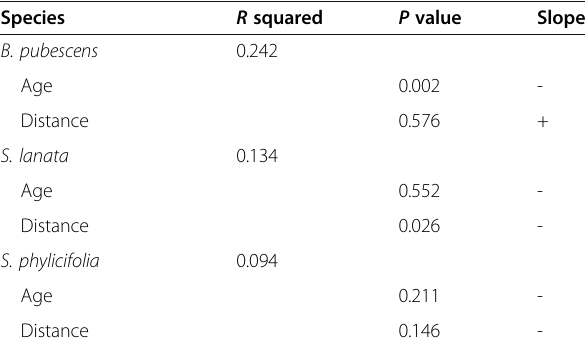
Table 5 Multiple linear regression analysis results testing data for size of specimens against factors of moraine age and distance from Skaftafelsheiði for B. pubescens and both Salix